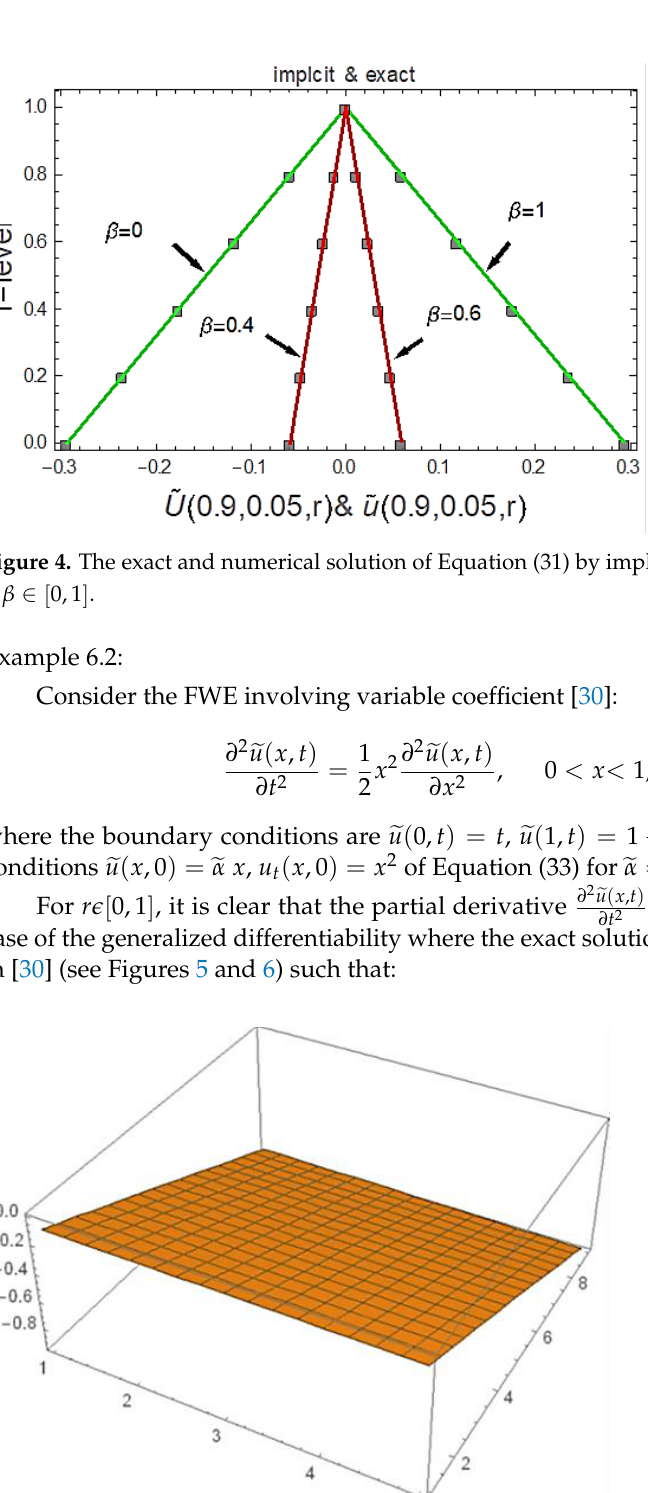
Figure 3. The exact and numerical solution of Equation (31) by CTCS and implicit schemes at 𝑡 =